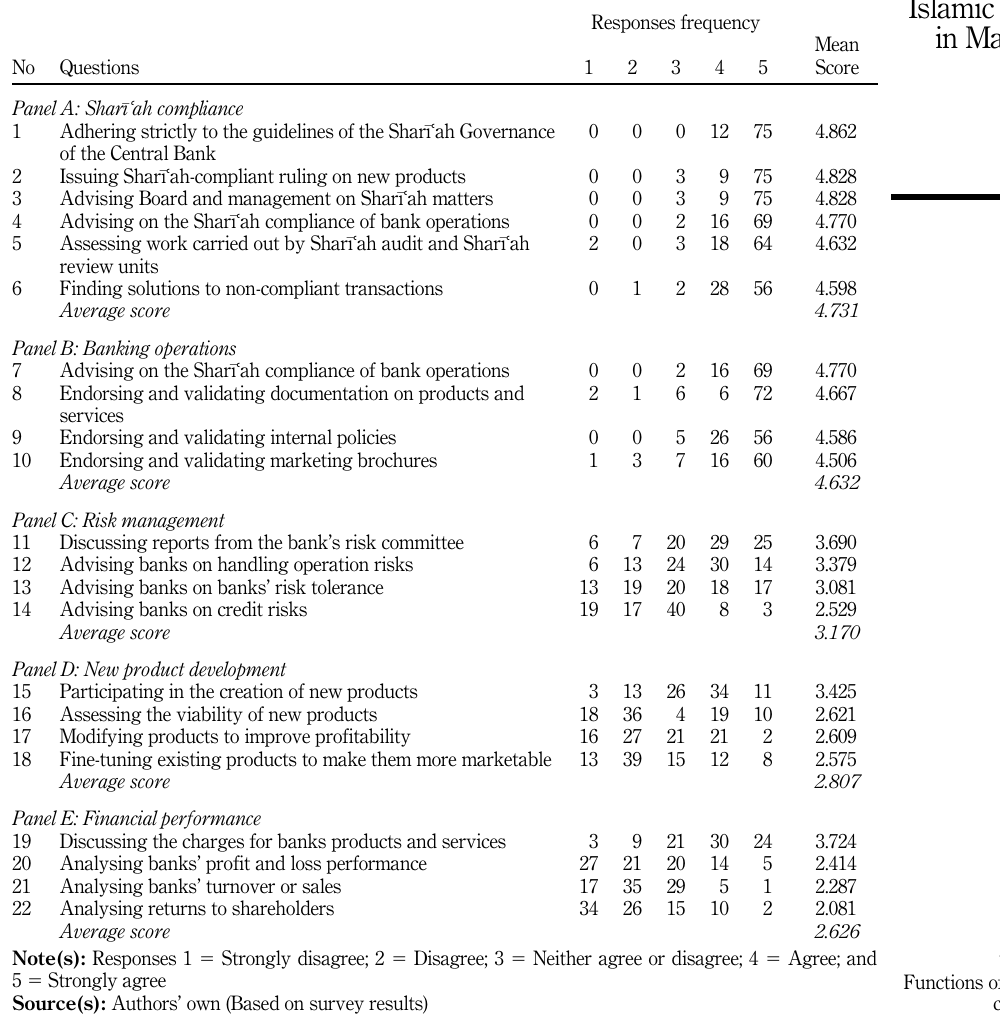
Table 3. Functions of Shar (cid:1) ı ʿ